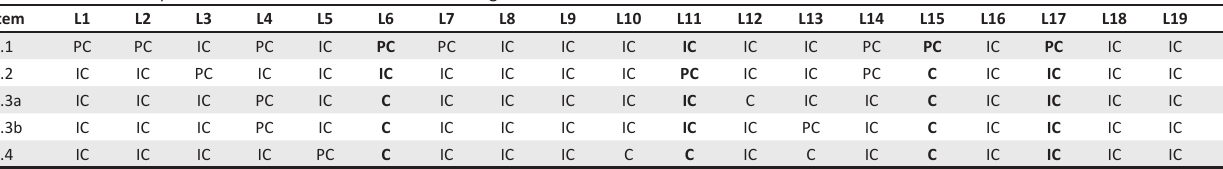
FIGURE 3: Written test (selection of four TABLE 1a: Learner responses to test items 1.1 to 1.4 in three categories.